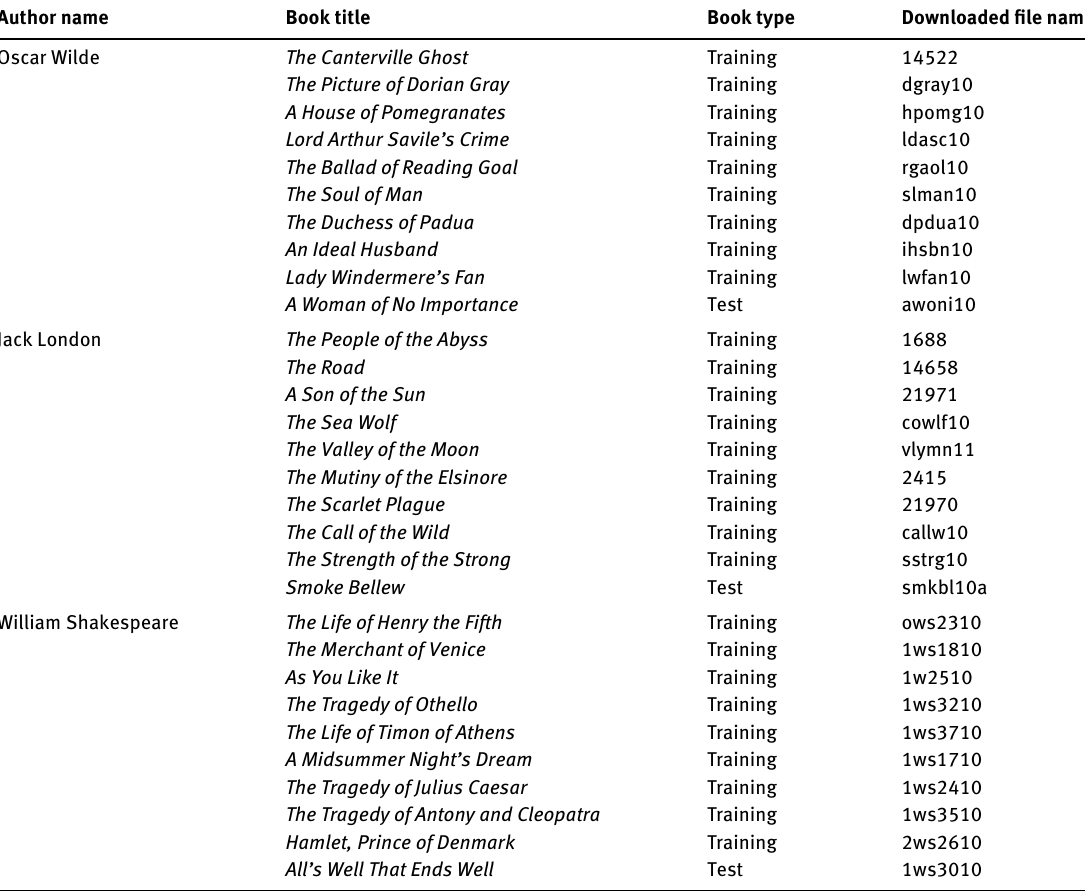
Table 1: Plays and Novels from Three Selected